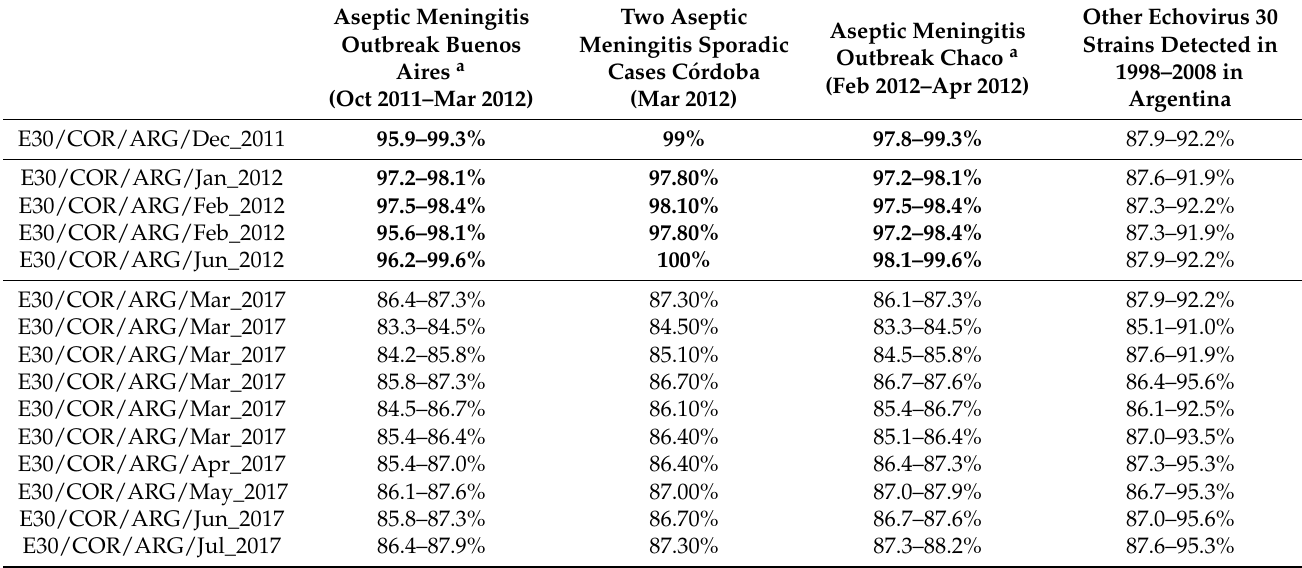
Table 3. Nucleotide identities among echovirus 30 strains detected in wastewater from C ó rdoba (in 2011, 2012, and 2017) and clinical isolates obtained from outbreaks and sporadic cases of aseptic meningitis accounted in Argentina between 1998 and 2012 reported by Lema et al., 2019